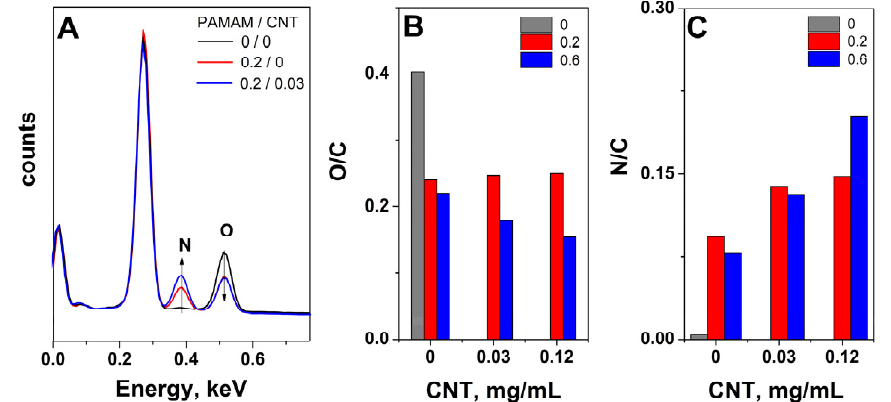
Figure 3. Typical EDS spectra of PAMAM/CNT-modified aerogels (mg mL − 1 ) ( A ); evolution of O/C at. ratio ( B ) and N/C at. ratio ( C ) for the PAMAM-modified aerogels (mg mL − 1 ) with CNT content.